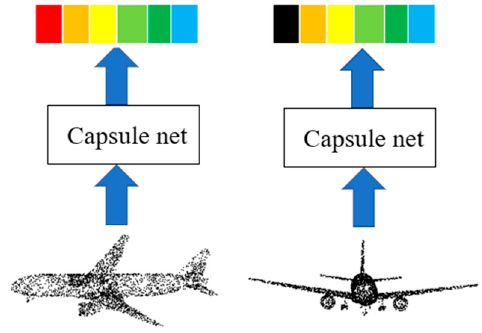
Figure 2. The equivariance of the capsule network.